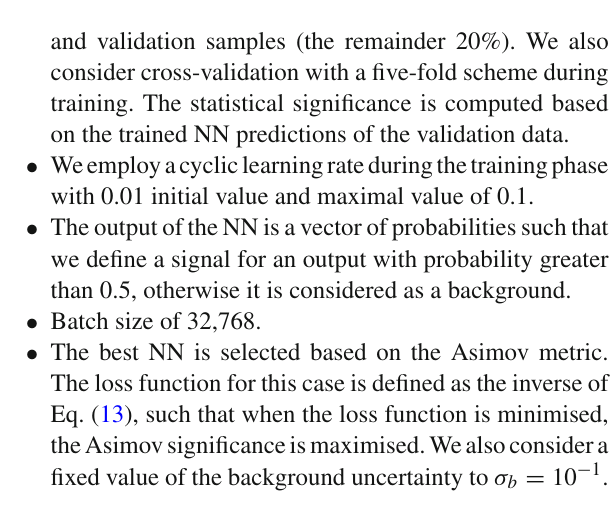
corresponding to all jet combinations, as described in the text. Vari- ables that involve combinations of final states, e.g. p T ( j a , j a ,μ − ) , are reconstructed from the states indicated inside the parenthesis